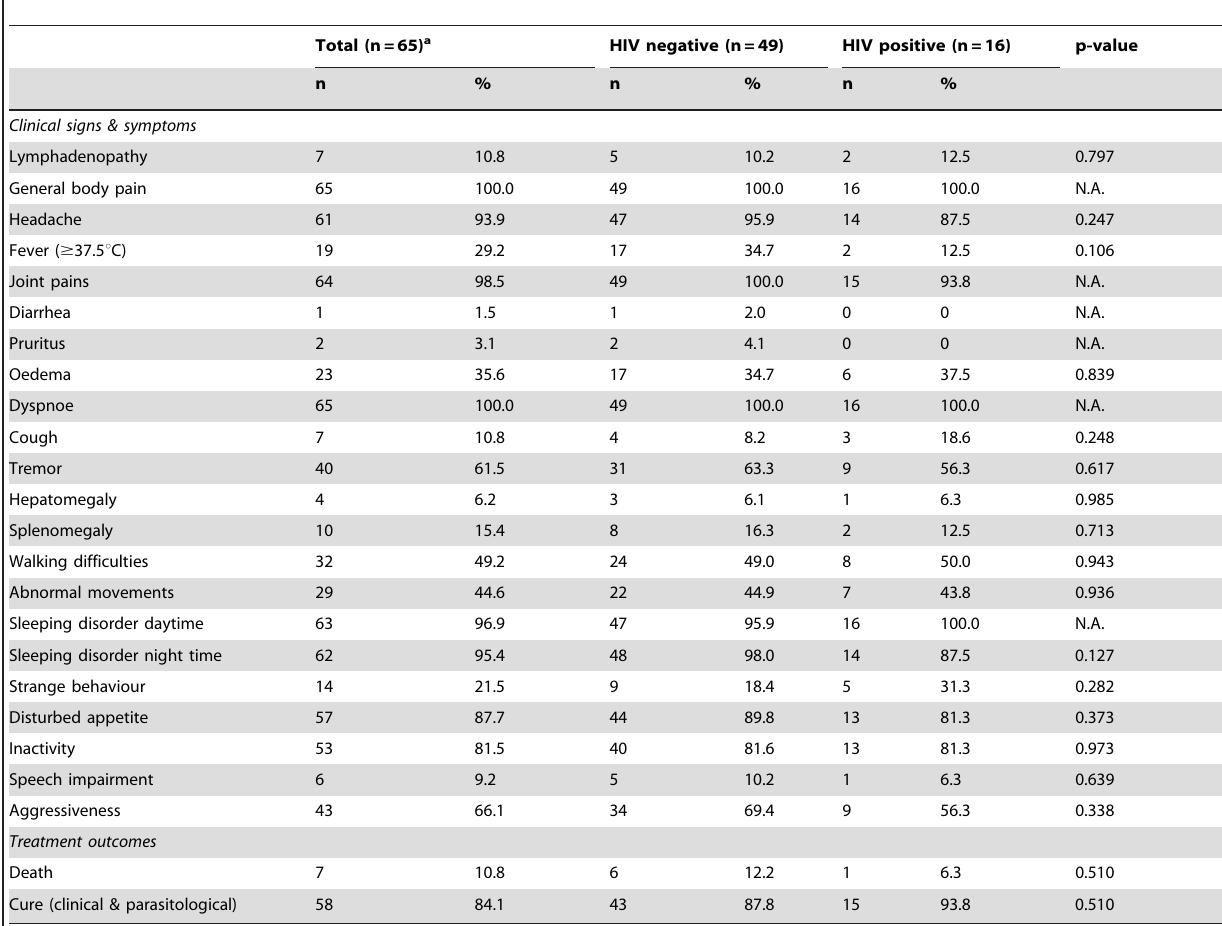
Table 5. Clinical signs and symptoms and treatment outcomes of HIV co-infected patients from